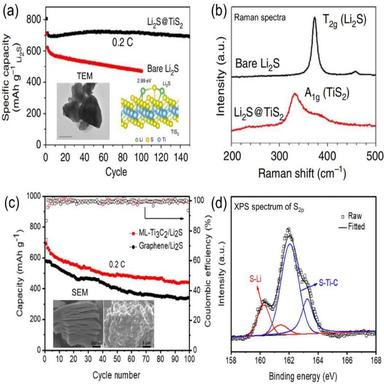
Characterization results of Li2S@TiS2 composite (a and b) and ML-Ti3C2/Li2S composite (c and d) . Reproduced from Refs. with permission from Springer Nature and Elsevier.